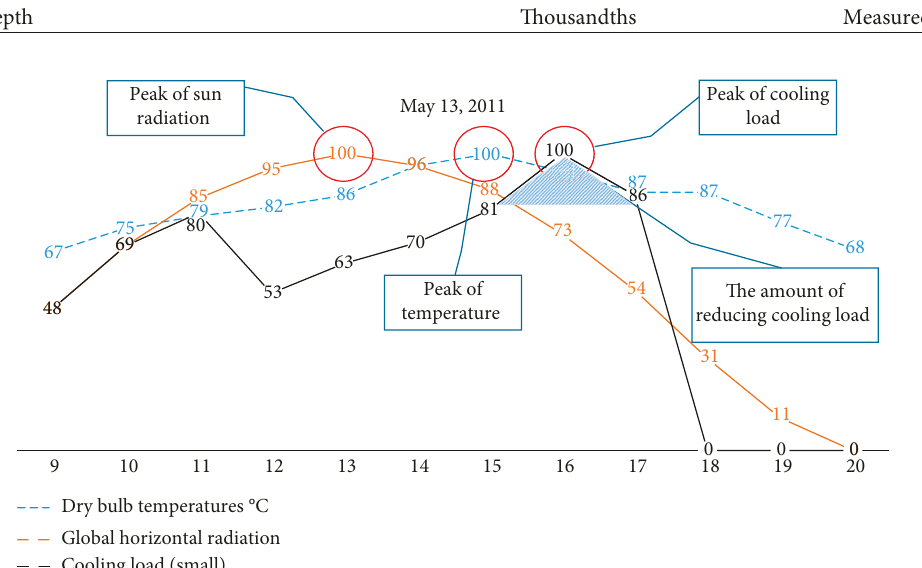
Figure 1: Time-lag